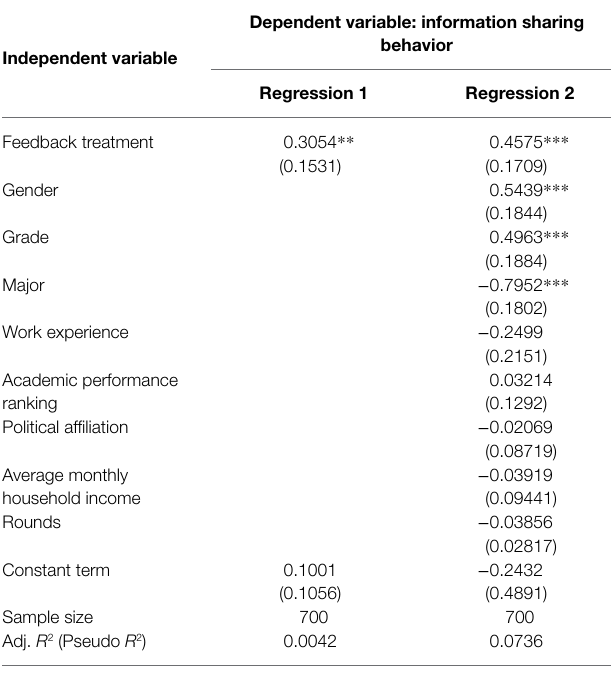
TABLE 6 | Reciprocity norms and information sharing